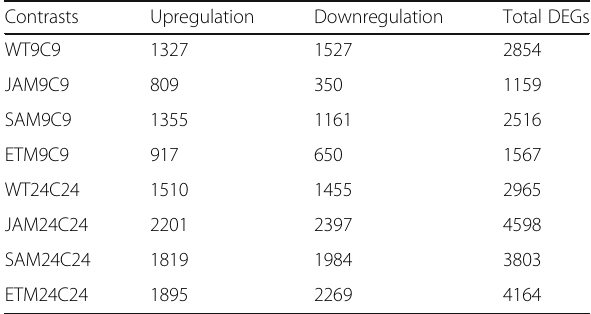
Table 1 Analysis of DEGs triggered during pathogenesis of Alternaria blight disease in comparison of wild-type pathogen- treated plant with control plant (WTC), jasmonic acid mutant pathogen-treated plant with control (JAMC), salicylic acid mutant pathogen-treated plant with control (SAMC), ethylene mutant-treated plant with control (ETMC) at 9 h and 24 h after Alternaria brassicicola infection on Arabidopsis thaliana